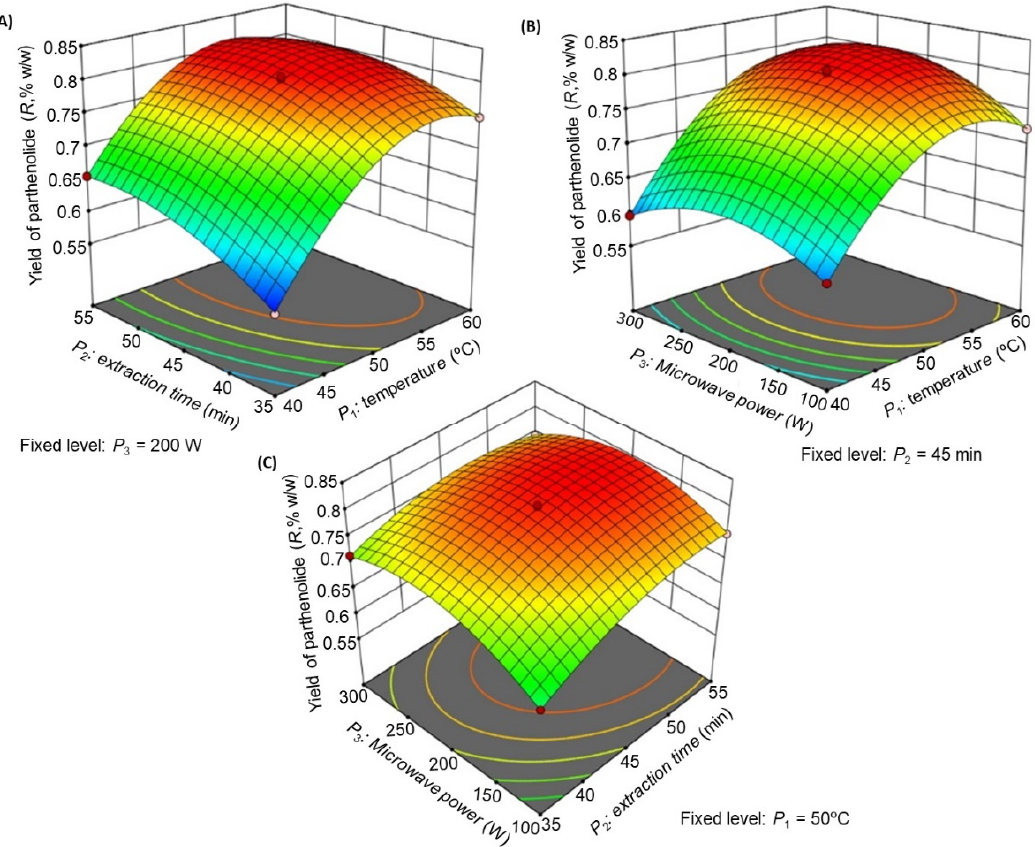
Figure 4. Response surface model 3D plots showing the effects of P 1 , P 2 , and P 3 on R . ( A ) Effect of P 1 and P 2 on R , ( B ) effect of P 1 and P 3 on R , and ( C ) effect of P 2 and P 3 on R .